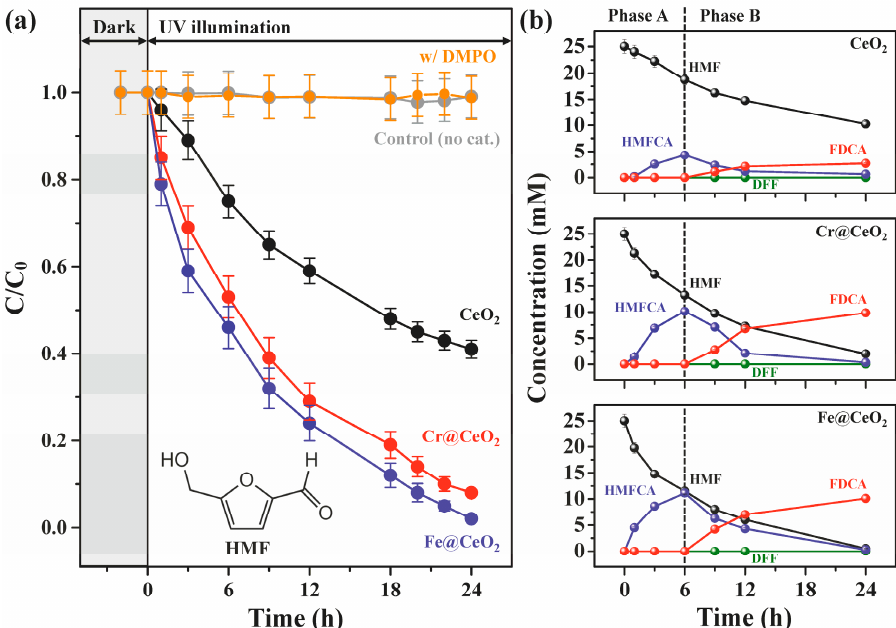
Figure 3. ( a ) PCD data with and without DMPO as a radical scavenger for the change in the relative amount of HMF and ( b ) quantitative analysis of products by photolysis of HMF under UV irradiation of 365 nm wavelength in the presence of CeO 2 , Cr@CeO 2 , and Fe@CeO 2 NPs. C 0 and C indicate the initial concentration and post-reaction concentration of HMF, respectively. Table 2. PCD performance and FDCA conversion yields determined through the photolysis of 25 mM HMF for 24 h under UV irradiation of 365 nm wavelength in the presence of CeO 2 , Cr@CeO 2 , and Fe@CeO 2 NPs; these are the data at 24 h in Figure 3.